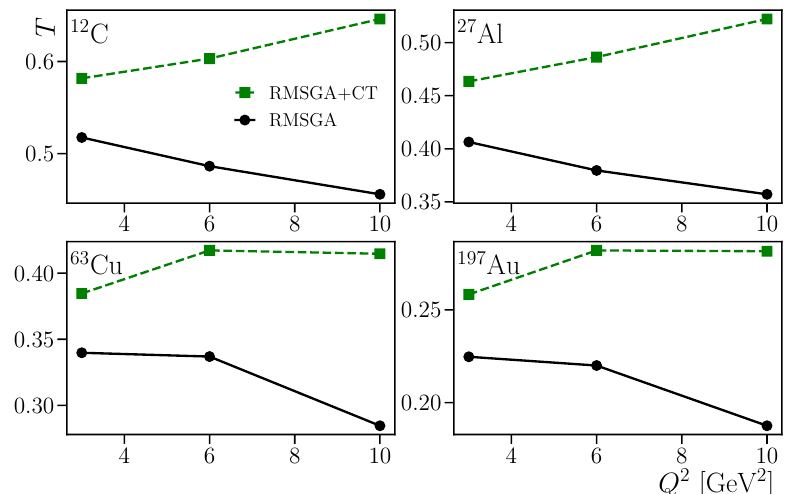
Figure 7. RMSGA nuclear transparency calculations for 12 C, 27 Al, 63 Cu, and 197 Au as a function of Q 2 . Full curves are regular Glauber calculations, the dashed curves include the color transparency in the quantum diffusion model. See text for